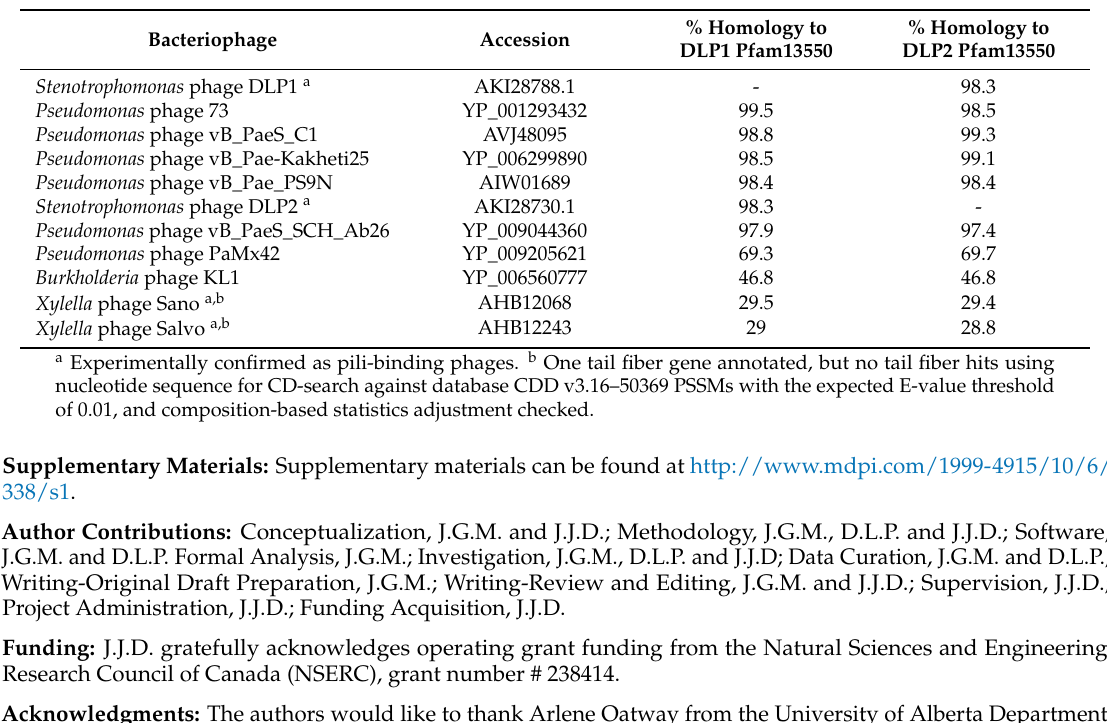
Table 4. Amino acid sequence comparison of DLP1 and DLP2 phage central tail hub proteins containing the Pfam13550 Phage-tail_3 domain of Siphoviridae